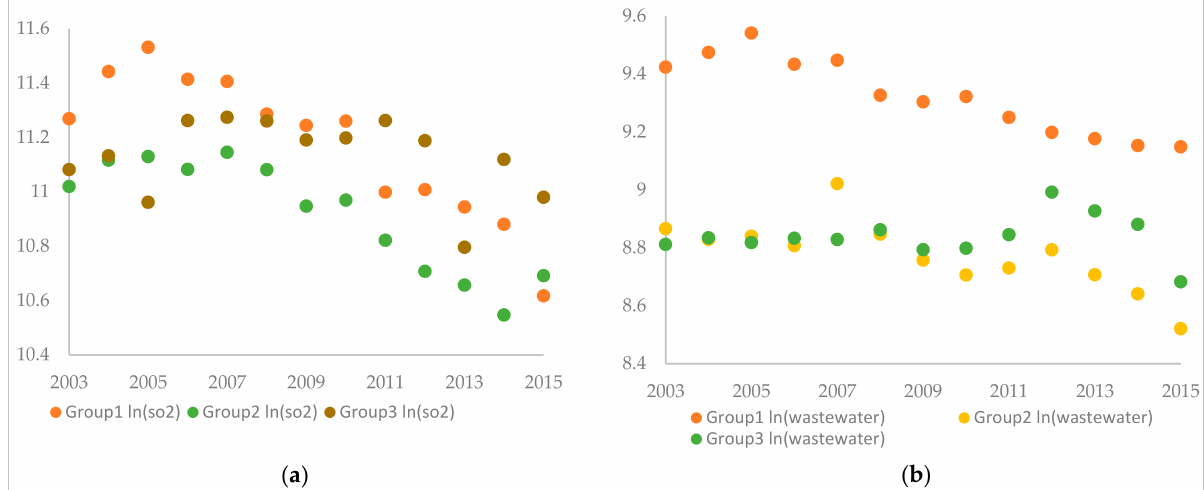
Figure 2. The evolutions of the year-average ln ( SO 2 ) and the year-average ln ( wastewater ) by group. Group 1, Group 2, Group 3, respectively, represents the first, the second, the third group of demonstration cities. ( a ) shows the year-average ln ( SO 2 ) vs. year, and ( b ) shows the year-average ln ( wastewater ) vs.